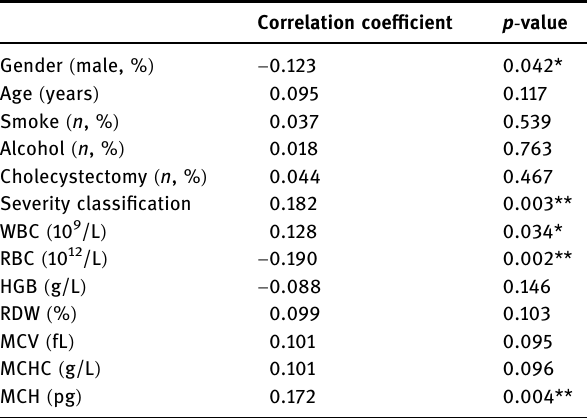
Table 3: The correlation between length of hospital stay and other laboratory data Correlation coe ffi cient